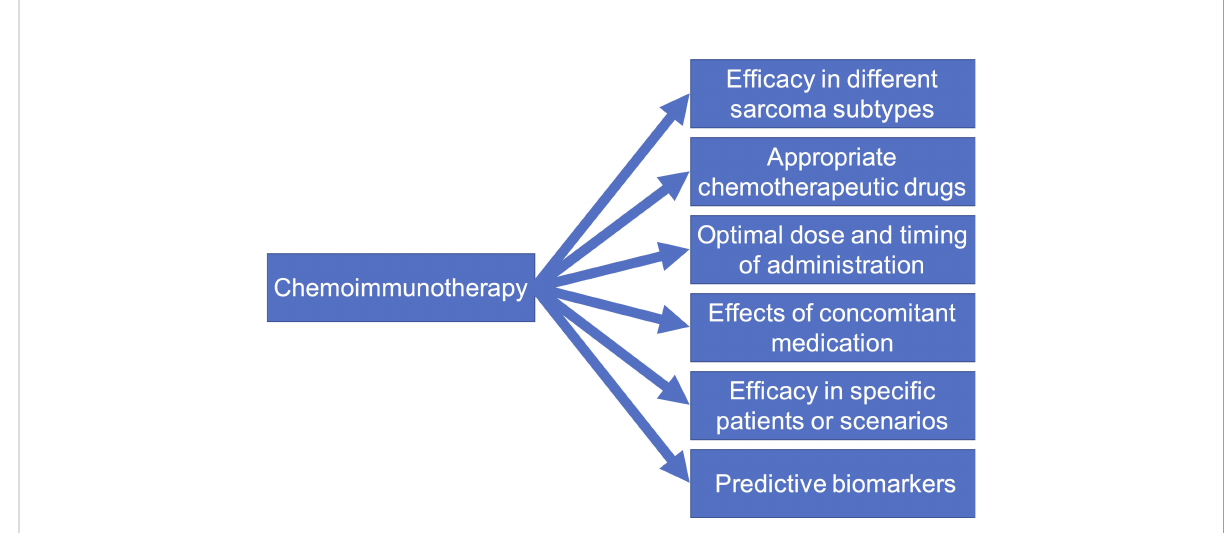
FIGURE 2 Six future directions for mechanism and clinical studies on PD-1/L1 inhibitor plus chemotherapy in soft-tissue